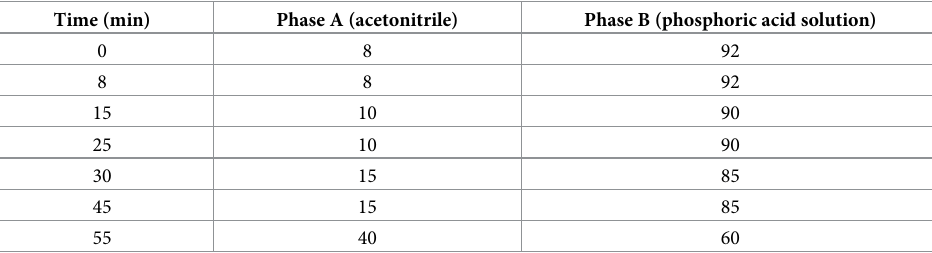
Table 1. Gradient concentrations of phases A and B in